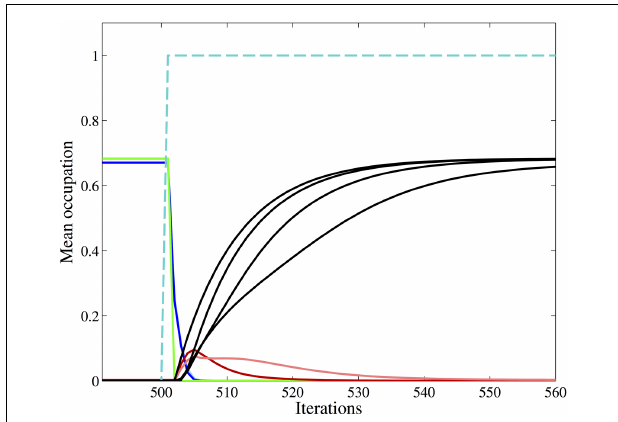
FIGURE 6 | Mean-field theory of a 12-group architecture with self .The figure shows the time series of the mean occupation per node of the 12 groups as obtained from iterating equation (7) for an influx probability p = 0.074.We start with the autonomous system in the steady state where singletons (green) and periphery (blue) have a mean occupation per node (cid:104) n (cid:105)≈ 0.68, whereas core (red) and stable holes (black) have (cid:104) n (cid:105)≈ 0.The color code is the same as in Figure 5A . At some arbitrary iteration step (here 500), we permanently occupy the 110 nodes of the hole group S 10 (dashed cyan line).The fixed point of equation (7) looses its stability and a new mirrored architecture emerges where the permanently occupied nodes, the self, now belong to the singletons, which have neighbors only in the empty hole groups, cf. Figure 5B .The occupation of the previous singleton (green line) and periphery (blue line) groups drops down to almost zero, whereas the previous hole groups (black lines) become occupied as typical for singletons and periphery. (The light blue line of the periphery group S 4 is not visible here since it is covered by the green line up to iteration step 500, and thereafter by the blue line.) After an temporary increase the core groups (red lines) return to its previous occupation. For a detailed comparison of steady state results of mean-field theory and simulation see Table 1